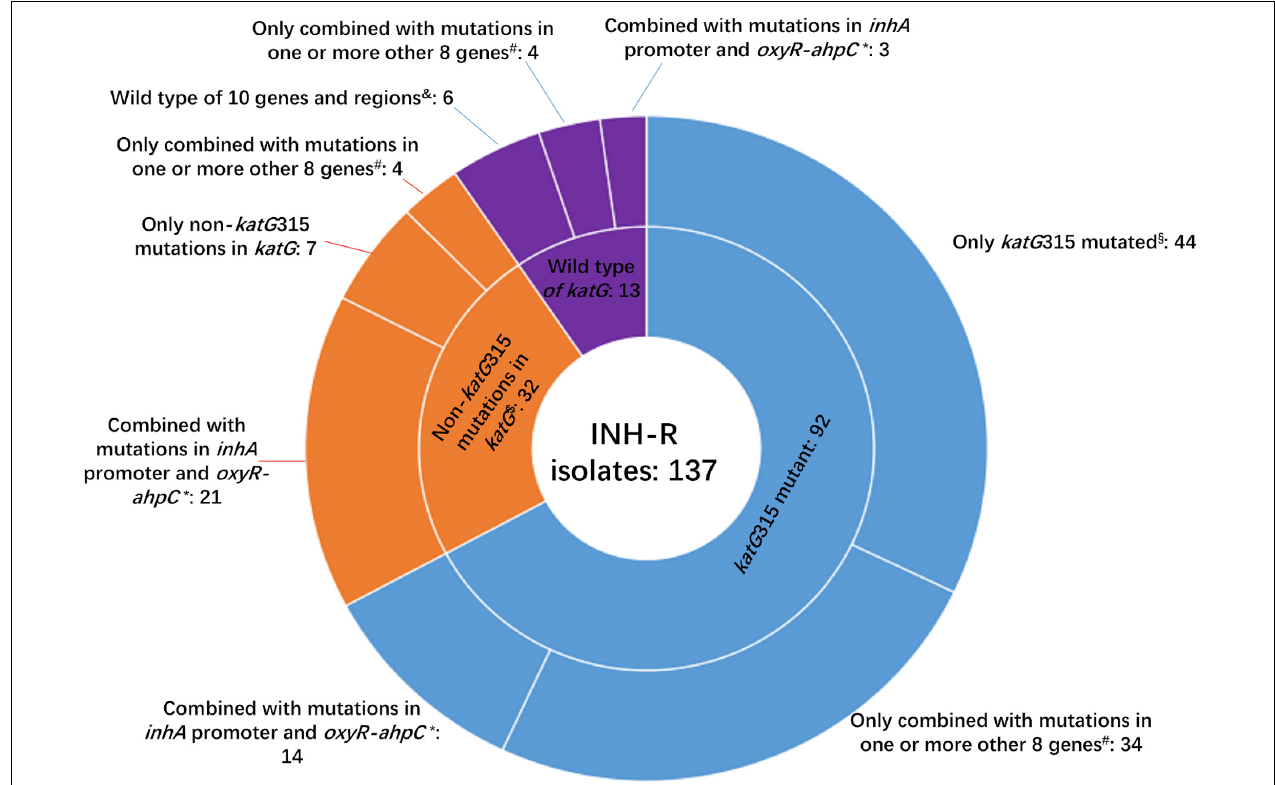
FIGURE 2 | Number of isolates carrying katG mutations combined with mutations in another 10 genes or intergenic regions among 137 MDR M. tuberculosis . INH-R, isoniazid resistant; *this group included isoniazid-resistant isolates that also carried mutations in ahpC coding region, inhA coding region, ndh , efpA , kasA , iniA , iniB, and/or iniC . # Eight genes included ahpC coding region, inhA coding region, ndh , efpA , kasA , iniA , iniB , and iniC ; $ two isolates that had mutations of katG 315 and other substitutes in katG were not included in this group. § This group included two isolates that had mutations of katG 315 and other substitutes in katG ; & 10 genes and regions included inhA promoter, oxyR - ahpC intergenic region, ahpC coding region, inhA coding region, ndh , efpA , kasA , iniA , iniB , and